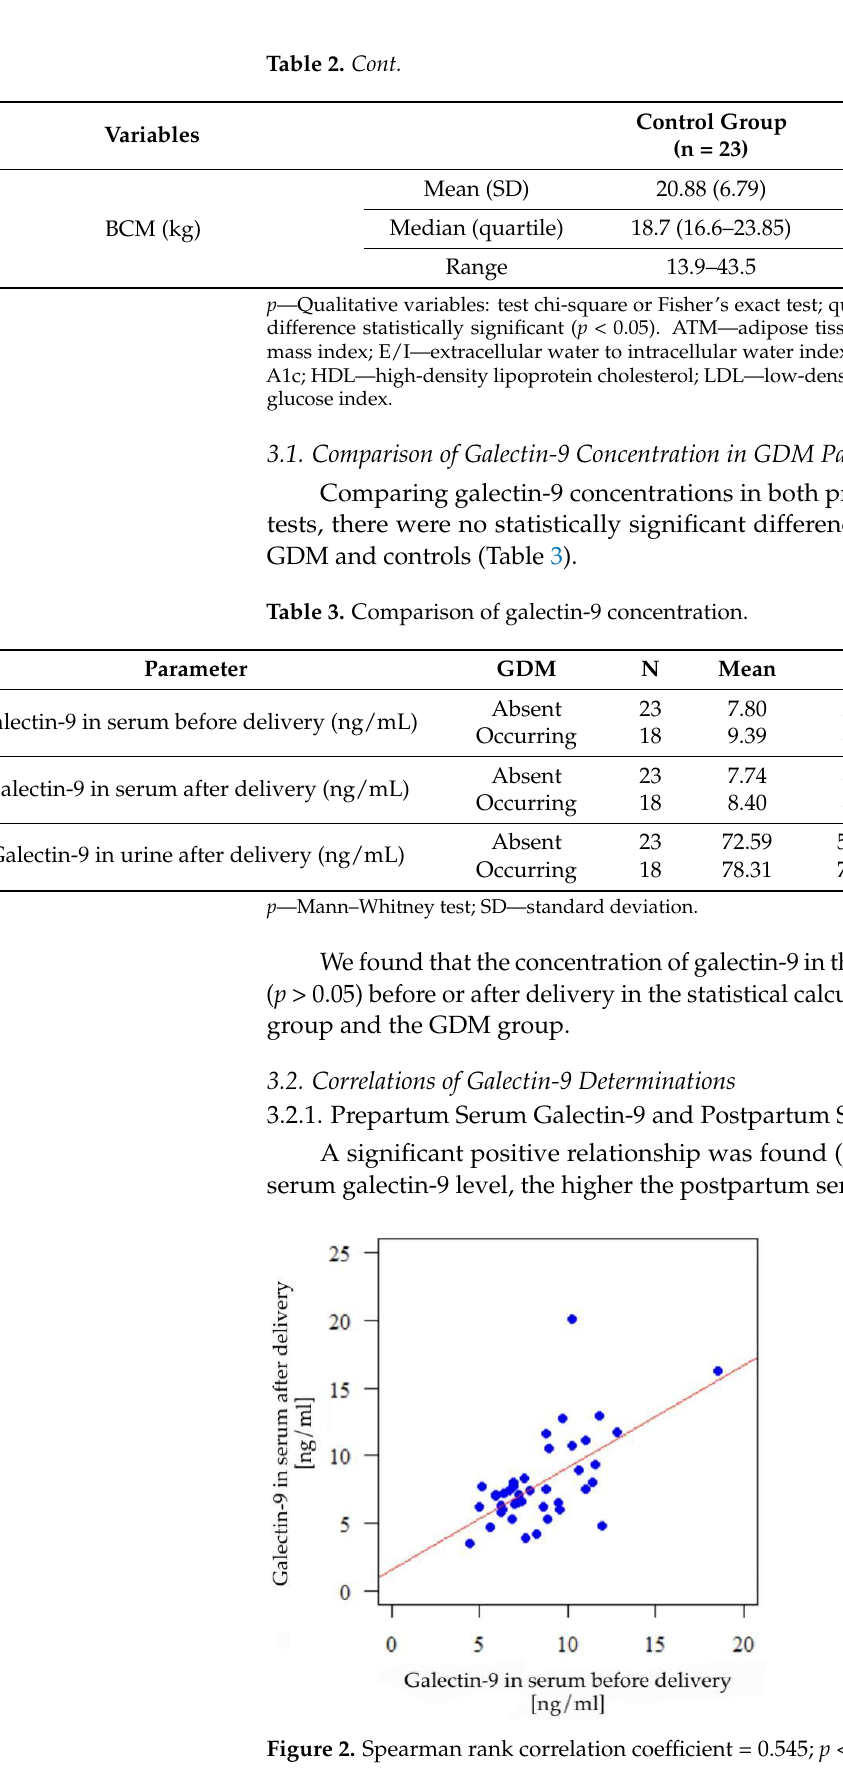
Figure 2. Spearman rank correlation coe ffi cient = 0.545; p < 0.001.